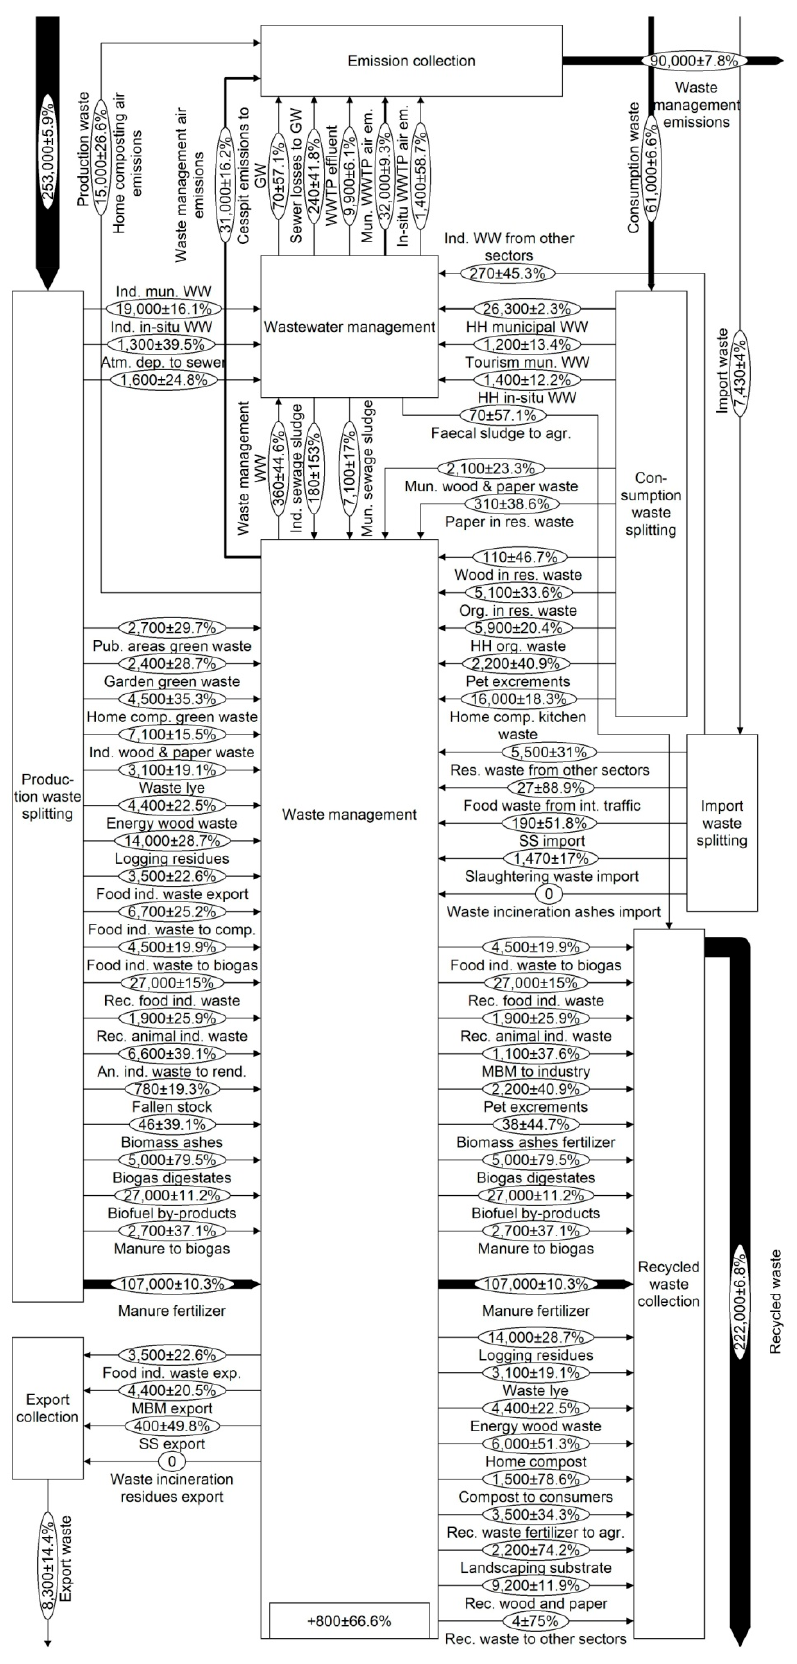
Figure A6. Austrian N system 2015, subsystem waste management.